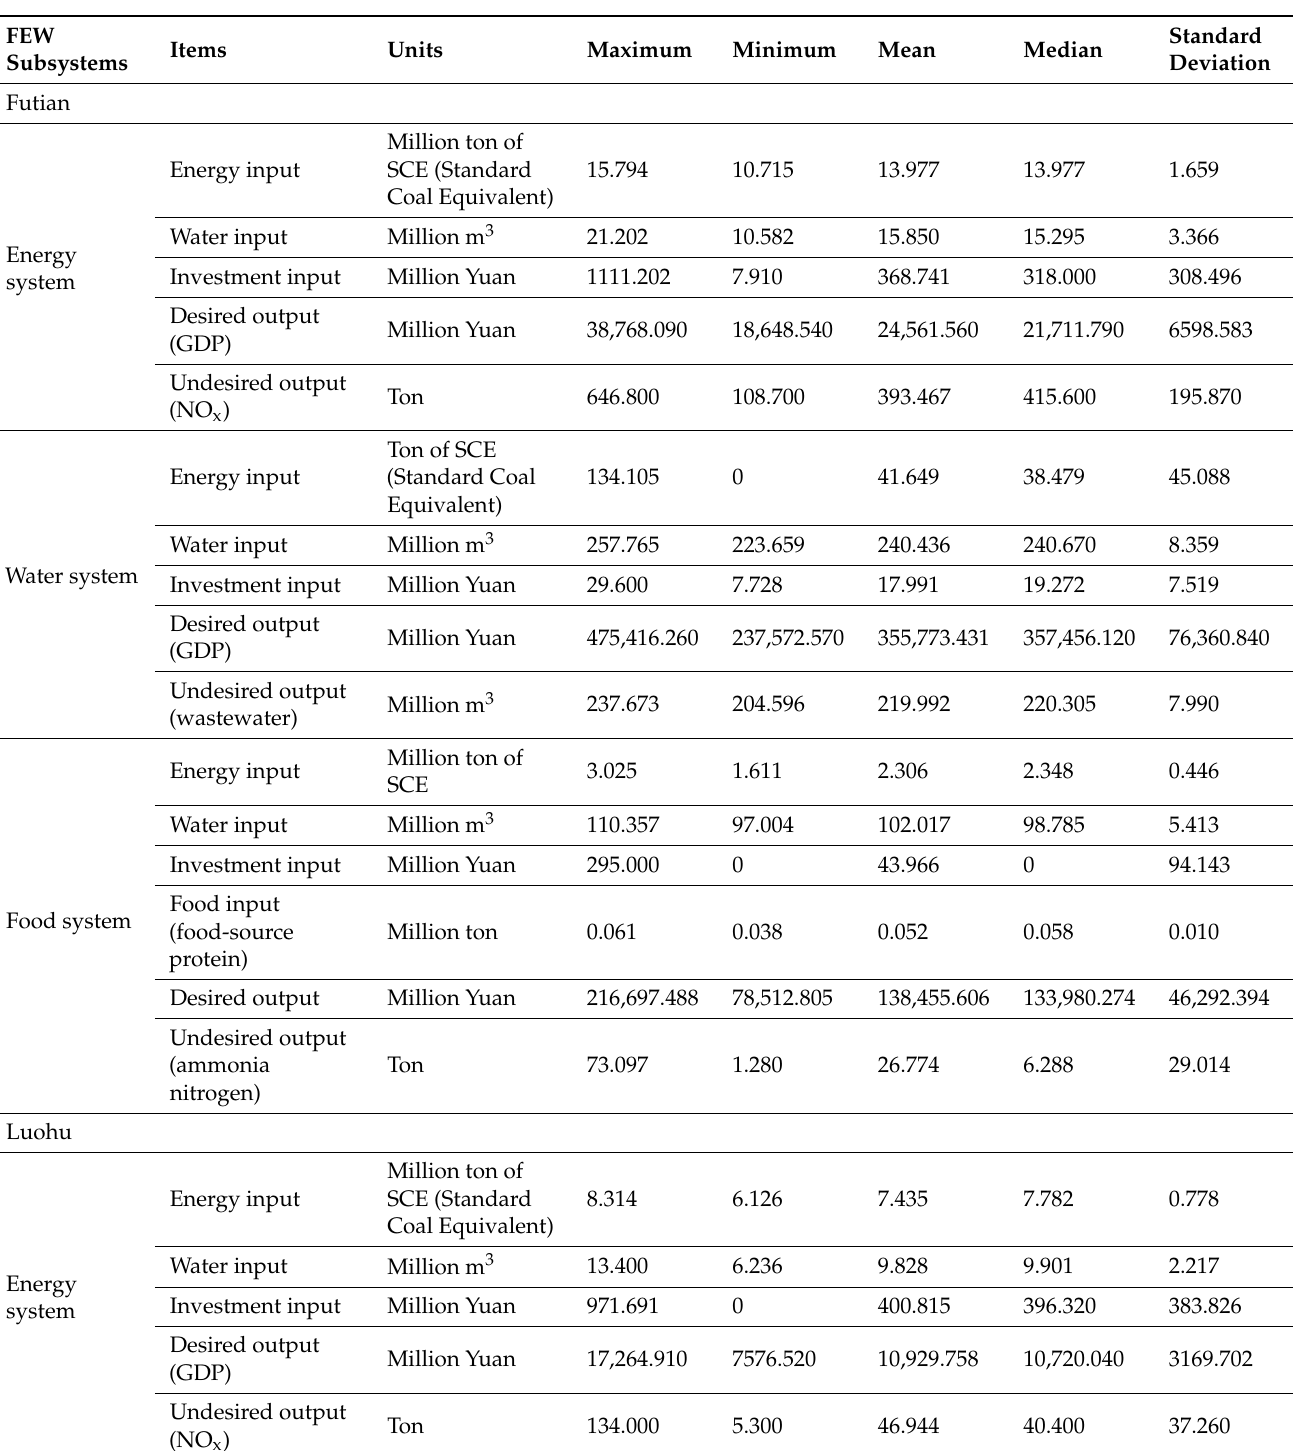
Table A1. The characteristics in numerous input and output indicators of DEA for coupling FEW efficiency